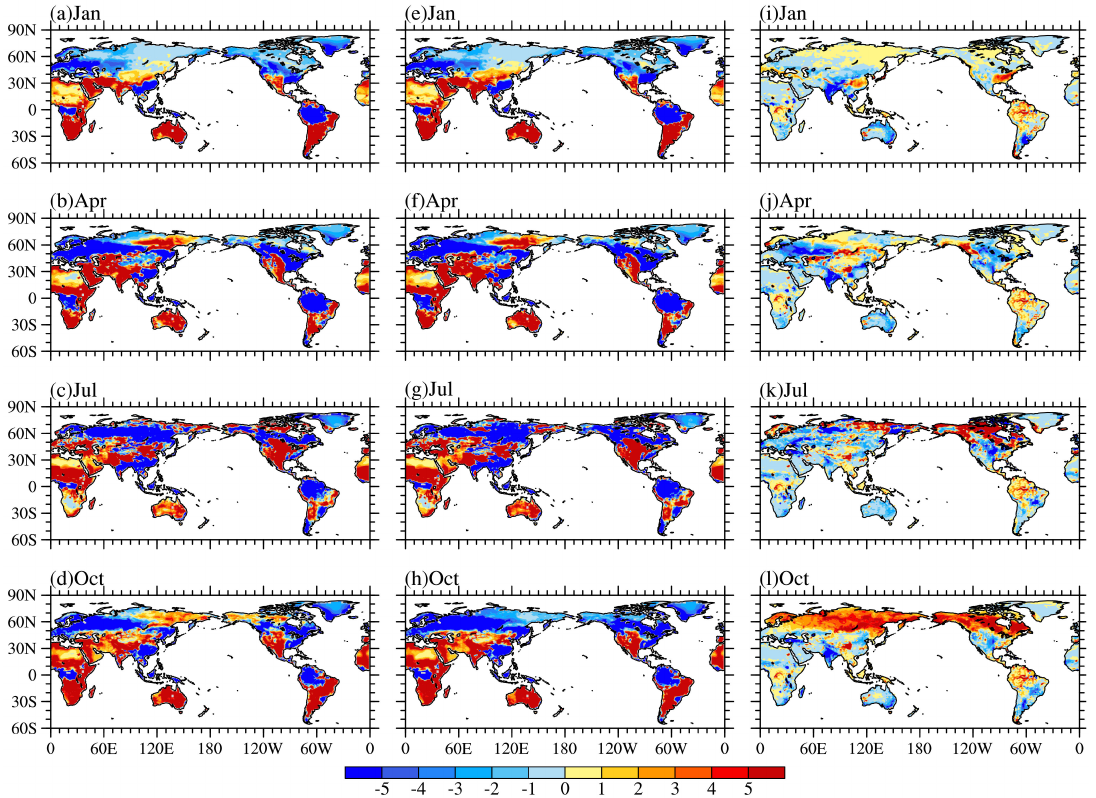
Figure 9. Spatial distribution of global Es (units: W/m 2 ): ( a – d ) difference between CLM4.5 and CFSR, ( e – h ) difference between CLM4.0 and CFSR, and ( i – l ) difference between CLM4.5 and